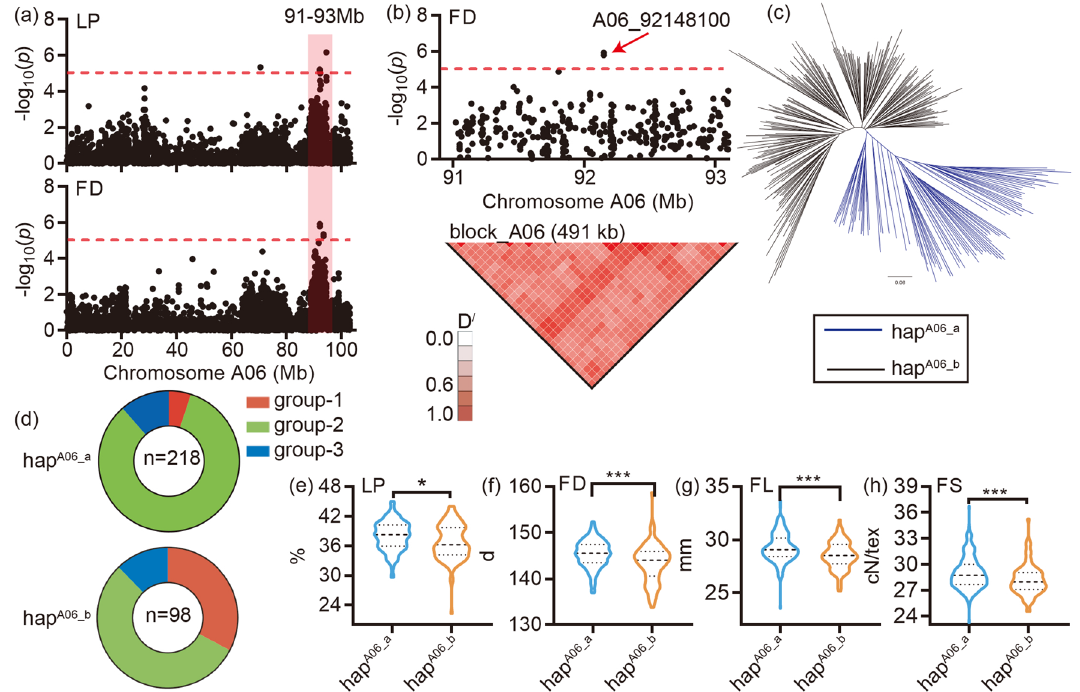
Figure 4. Identification and genotyping of the pleotropic region LD block 1 on chromosome A06. ( a ) The Manhattan block of the LP and FD, the horizontal dashed lines indicate the significance threshold (− log 10 ( P ) > 5.27). The red box indicates the region identified by the GWAS of LP and FD, located between 91 and 93 Mb on A06 chromosome; ( b ) Local Manhattan block (top) and LD heat map (bottom). The red arrows indicate the most significance SNP in the LD block at the top; ( c ) A neighbor-joining tree was constructed using the SNP data located in the LD block 3. The accessions were divided into two groups, hap A06_a and hap A06_b ; ( d ) The composition of the two haplotypes, group-1 (red), group-2 (cyan) and group-3 (blue); ( e ) Box plots for LP, FD, FL and FS for the two haplotypes (n = 218 and 98). Center line, median; box limits, upper and lower quartiles; whiskers, 1.5× the interquartile range; dots, outliers (* P < 0.05, ** P < 0.01 and *** P < 0.001, two- sided t-test). The neighbor-joining tree ( c ) was constructed using the software PHYLIP (v3.696, https:// evolu tion. genet ics. washi ngton. edu/ phylip. html). The LD heatmap (the bottom of b ) was created by the Haploview software (https:// www. broad insti tute. org/ haplo view/ haplo view). The others were created by the software